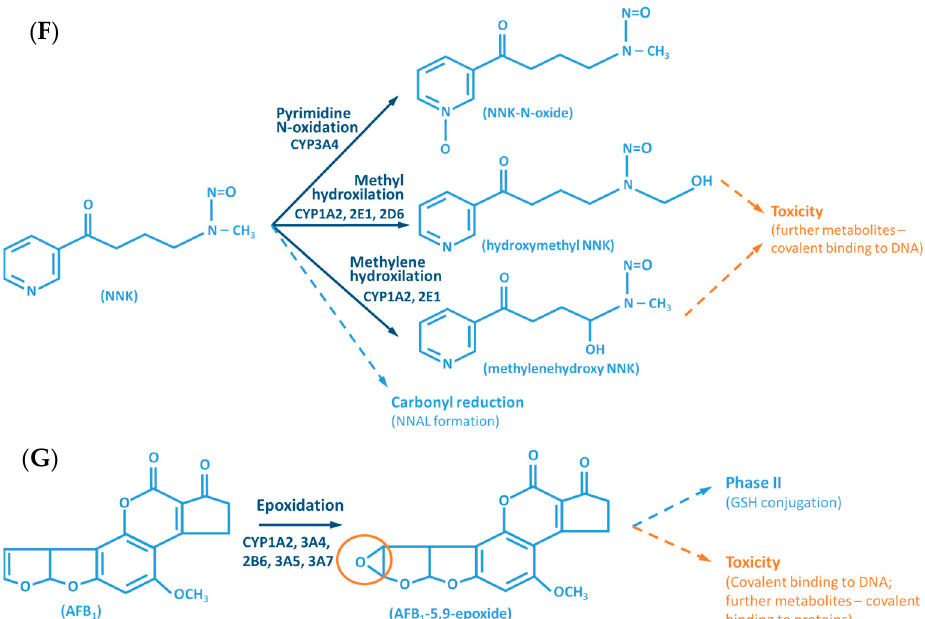
Figure 2. Examples of reactions catalyzed by CYPs. ( A ) CYP-mediated bioactivation of thalidomide. ( B ) CYP-mediated hydroxylation of phenol. ( C ) CYP-mediated metabolism of caffeine, with multiple metabolites. ( D ) Bioactivation of benzo[a]pyrene mediated by CYP enzymes. ( E ) CYP-mediated metabolism of paracetamol and its potential toxicity. ( F ) CYP-mediated bioactivation of NNK. ( G ) Bioactivation of aflatoxin B 1 by CYP enzymes. AFB 1 : Aflatoxin B 1 . APAP: acetaminophen; B[a]P: benzo[a]pyrene; BPDE: benzo[a]pyrene diol epoxide; DMX: dimethylxanthine; GST: glutathione S-transferases; NAPQI: N-acetyl-p-benzoquinone imine; NNAL: 4-(methylnitrosamino)-1-(3-pyridyl)-1-butanol; NNK: nitrosamine 4-(methylnitrosamino)-1-(3-pyridyl)-1-butanone; PST: phenol sulfotransferase; SULT: sulfotransferases; TMX: trimethylxanthine; UGT: UDP-glucuronosyltransferases.